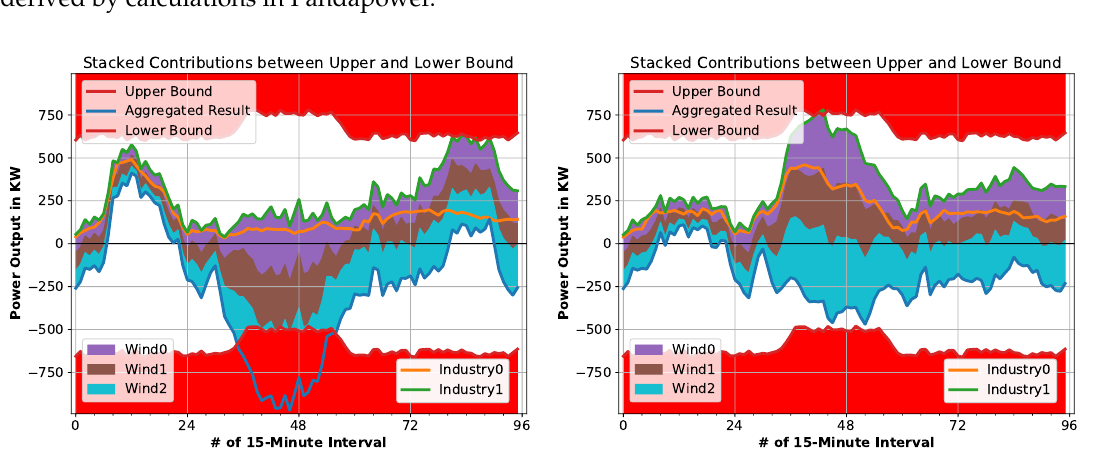
Figure 7. Simulation results of the technical virtual power plant (TVPP) in the example case described in Section 2.6. The left plot shows the situation before optimization of the TVPP and the right plot after